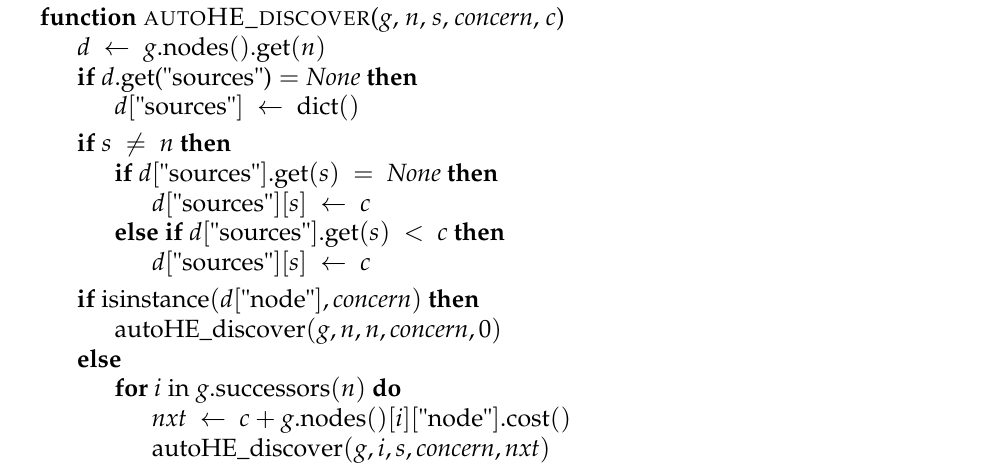
Algorithm 7 Recursive FHE parameterisation source and cost discovery over multi- directed